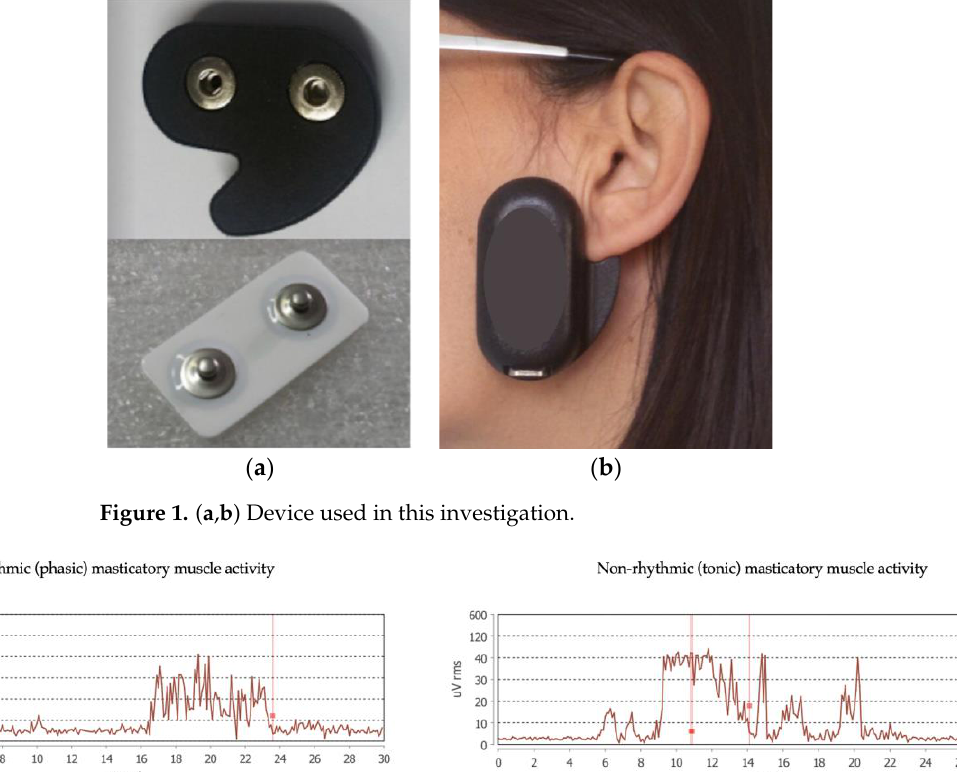
Figure 3. Example traces of physiological activities of the masseter muscle. 3. Results Of the 19 candidate volunteers, 4 were not eligible for the study because of a history of TMD pain (N = 2) or the presence of systemic rheumatic disease (N = 2). This led to a final sample of 15 participants (8 males and 7 females; mean age: 48.2 ± 4.1 years) taking part to the study. Descriptive statistics for each variable, expressed as mean values, standard devia- tions, minimums, and maximums, are presented in Tables 1 and 2. For the fifteen healthy volunteers, the mean total recording time was 23.9 ± 0.5 h; in detail, the sleep duration was 8.4 ± 0.7 h during the recording night, and no considerable sleep interruptions that might have influenced the outcomes were reported by any sub- jects, while the awake recording duration was 15.5 ± 1.2 h. The electrode dislodgement time was, on average, 26.2 ± 58.5 min per patient, with a minimum of 0 min and a maxi- mum of 200 over the 24 h EMG recording (Table 1). On average, the awake BTI and BWI were 0.9 ± 0.5 and 0.4 ± 0.2, respectively, while the mean BTI and BWI for sleep were 0.3 ± 0.1 and 0.1 ± 0.1 (Table 2).